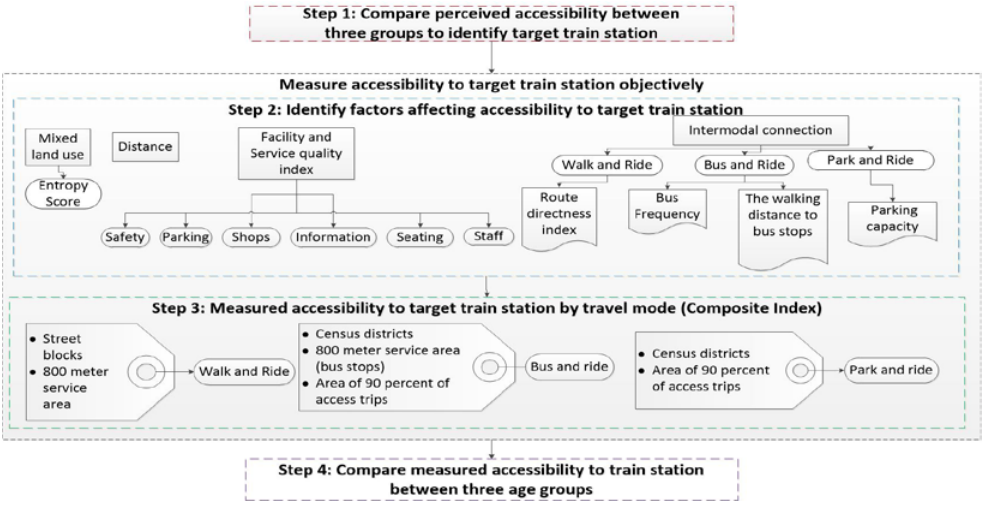
Figure 2. The framework of commuters' accessibility to a railway